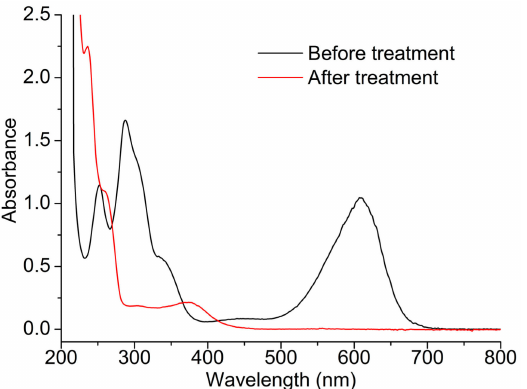
Figure 5. UV-vis absorption spectra of indigo carmine before and after treatment by D501G.